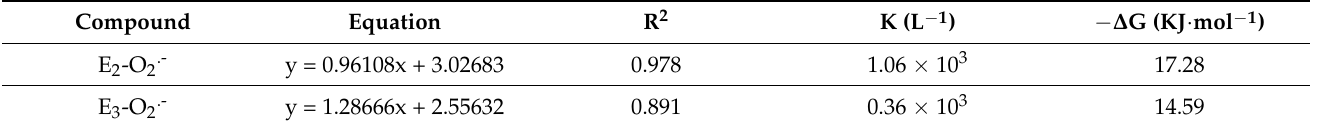
Table 8. Binding constant values for E 2 and E 3 with O 2.- from CV data at T = 298 K.